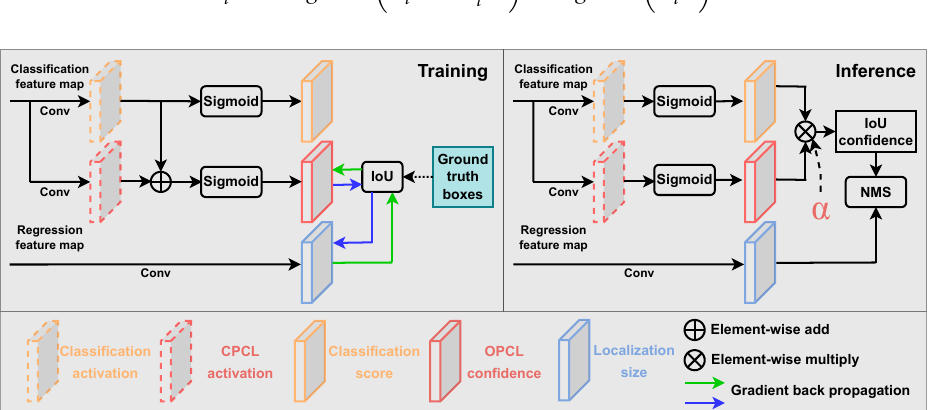
Figure 6. Illustration of the OPCL module, which contains training and inference pipelines. The clas- sification and regression feature maps were achieved by conducting four stacked convolution layers with BN and ReLU. The classification and OPCL branches were attached on the same feature